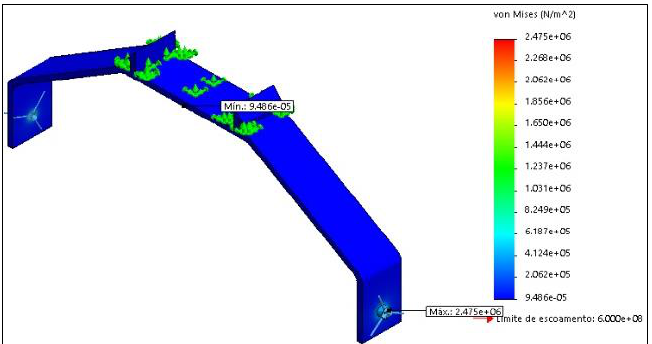
Figure 8: Result of stress analysis of the conceptual landing gear. Source: Authors, (2021).